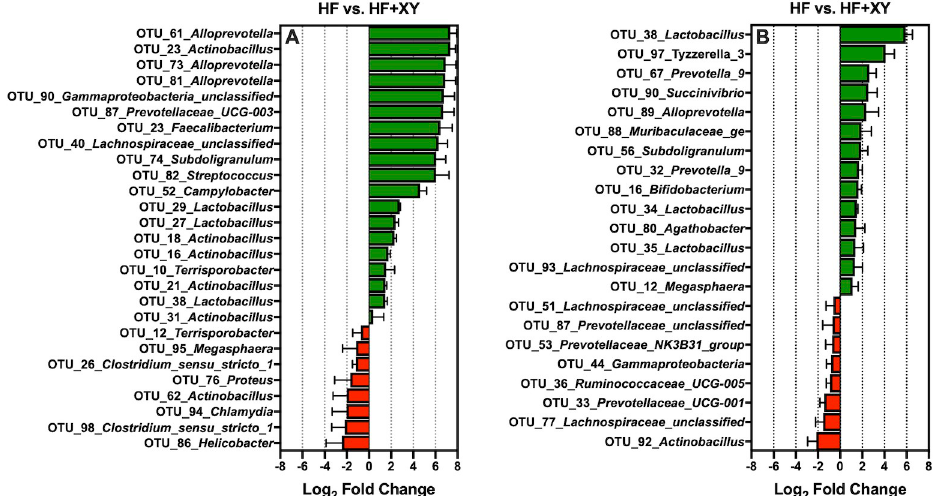
Fig 6. The log 2 -fold change differences between HF vs. HF+XY for the significant OTUs from the 100 most abundant OTUs among treatments present in the ileal digesta (A) and mucosa (B).